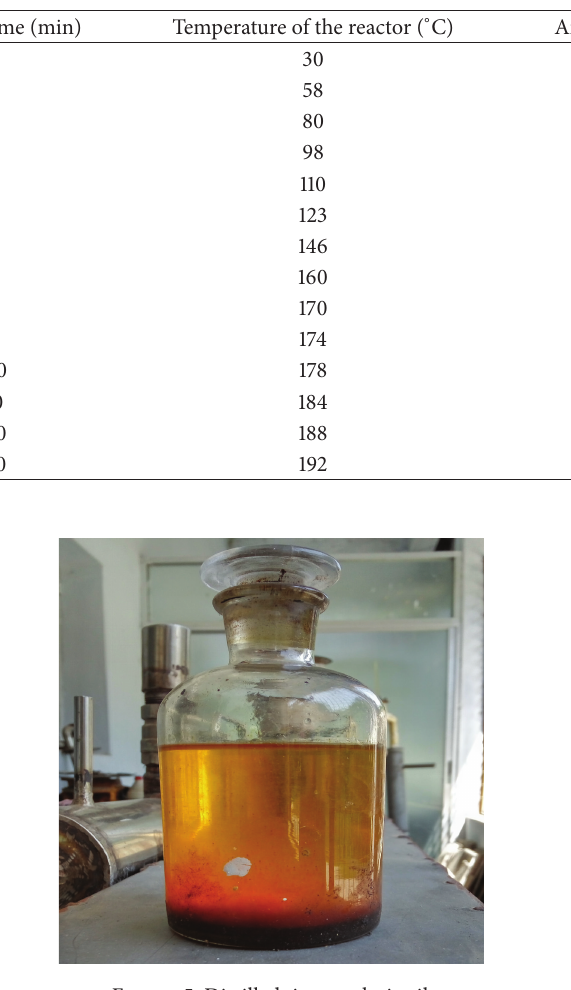
Figure 5: Distilled tire pyrolysis oil.